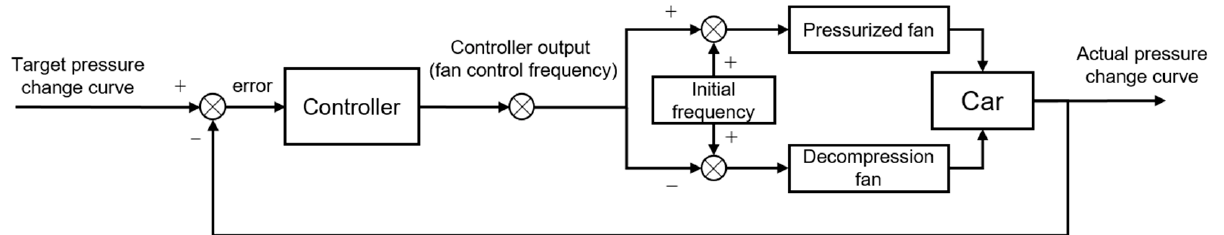
Figure 4. The dual-fan air pressure compensation system with a feedback link. When there is a pressure difference between the inside and outside of the car, the fan speed is changed by changing the fan frequency, thereby realizing the control of the air flow and the air pressure adjustment in the car. During the adjustment process, the